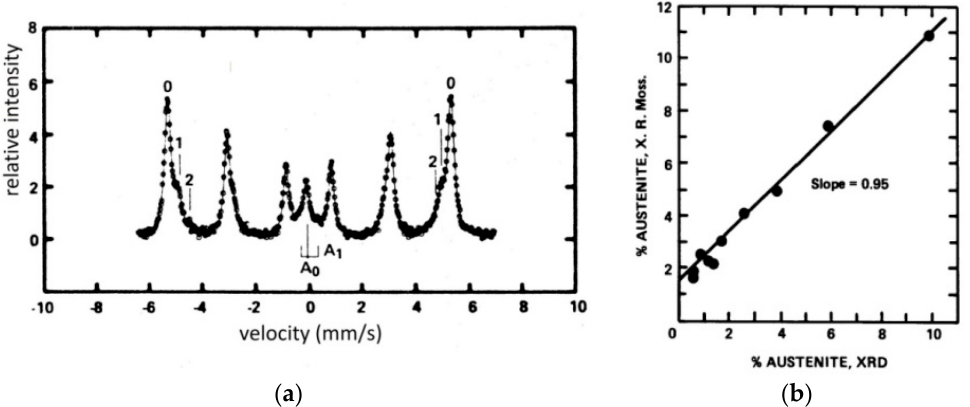
Figure 10. Mössbauer spectrum of a dual-phase steel ( a ) obtained with the conversion X-ray Mössbauer spectroscopy (CXMS) technique. The central peak of austenite is actually built up by the superposition of a singlet A 0 and a doublet A 1 . The magnetic contribution is owing to three sextets with 0, 1, and 2 external lines. Percent ( b ) of austenite determined by CXMS as a function of percent determined by X-ray di ff raction (XRD). Reproduced from [27], with permission from AIP Publishing, 1939.